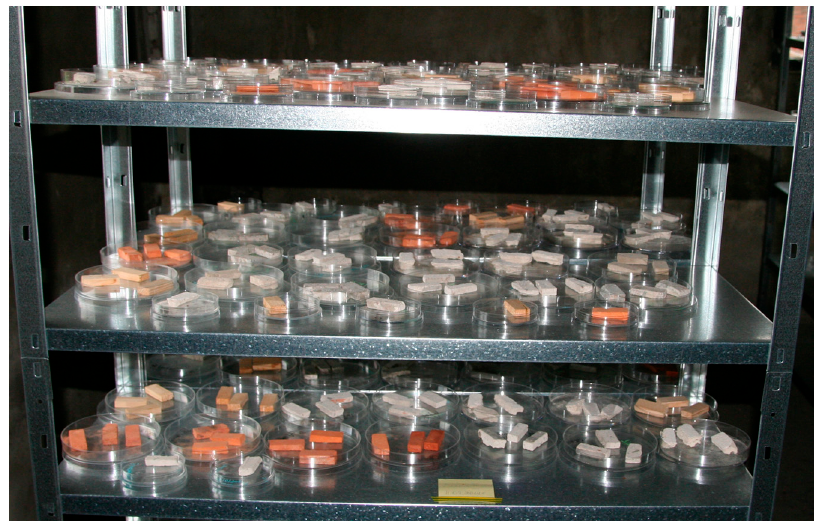
Figure 2. Historical wood samples after application of disinfectants, exposed in a barrack at the former Auschwitz II-Birkenau concentration and extermination camp.